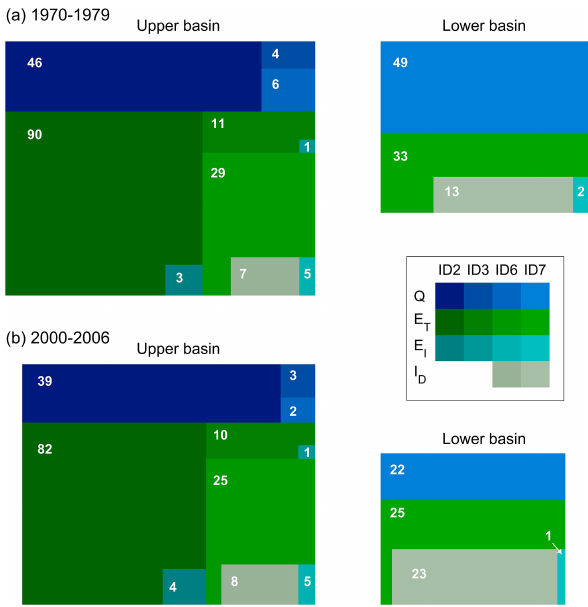
Figure 11. Water balances of the upper and the lower basins, respec- tively, for (a) the 1970–1979 and (b) the 2000–2006 periods. The size of the outer squares is equivalent to the total water available, i.e., for the upper-basin precipitation P and for the lower-basin pre- cipitation P plus the combined inflow Q from the upper basin. The size of the internal rectangles of each flux ( Q : streamflow; E T : tran- spiration; E I : interception evaporation; and I D : irrigation demand) in each sub-basin is equivalent to its fraction of the total available water in the upper and lower basin, respectively. The fluxes repre- sent the decadal mean values and are shown in mmyr − 1